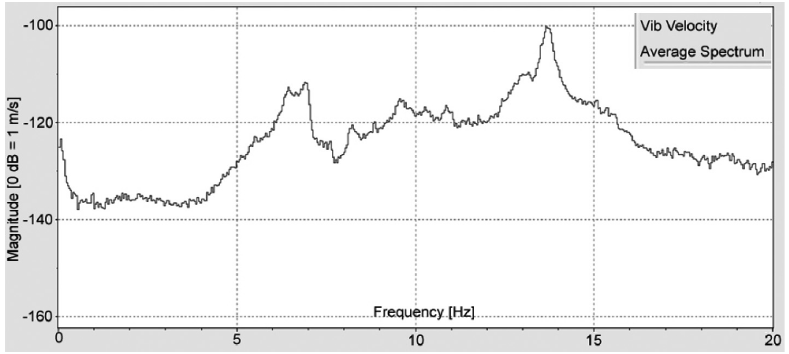
Fig. 11. Averaged vibrometer signal determined during the OMA measurement.